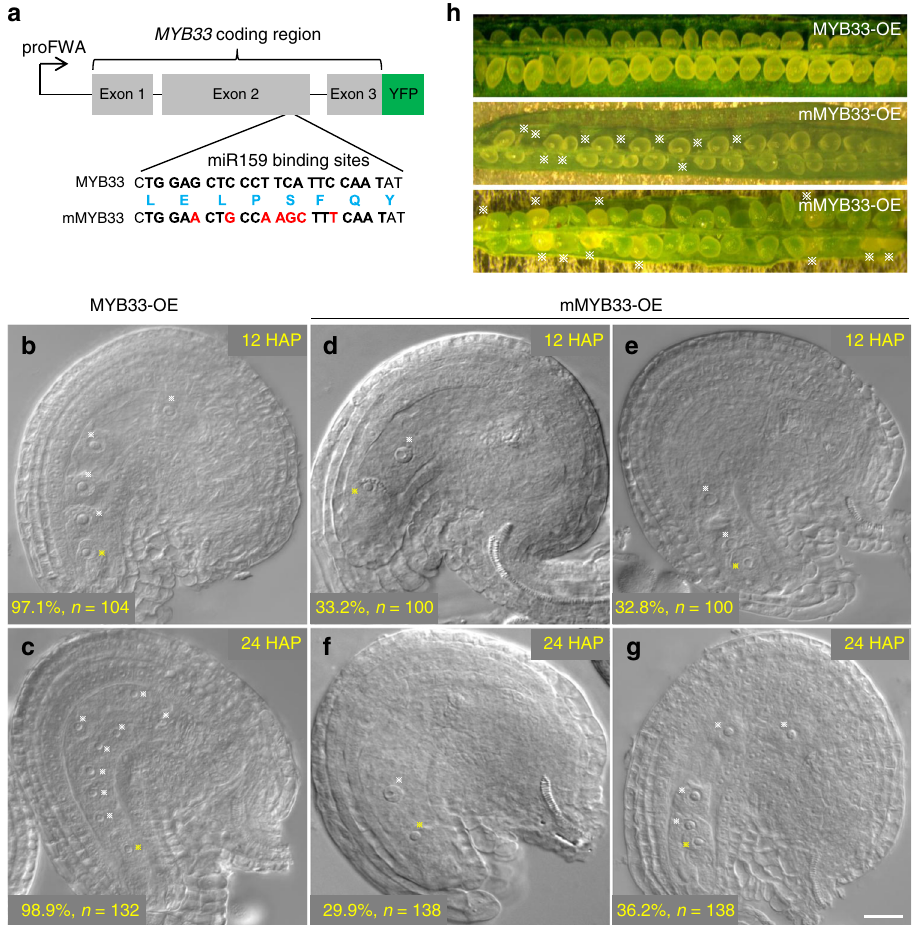
Fig. 5 Over-expression of mMYB33 causes defective endosperm nuclear divisions. The proFWA::MYB33-YFP (MYB33-OE) or proFWA::mMYB33-YFP (mMYB33-OE) transgene driven by the FWA promoter made in the vector pB7YWG2. The alteration to the nucleotide sequence in the miR159 binding sites of MYB33 is shown, and nucleotides highlighted in red for mMYB33 are those differing from the wild type ( MYB33 ). The unaltered amino acid sequences are shown in blue. The nucleotides in bold indicate the 21 nt miR159 binding sites. Gray boxes indicate three exons of MYB33 . b – g DIC imaging of endosperm nuclear divisions from MYB33-OE b , c and mMYB33-OE d – g transgenic plants at indicated time (HAP), respectively. White stars indicate endosperm nuclei or the central cell nucleus. Yellow stars indicate the fused nucleus by the egg cell and the sperm. % indicates the ratio of developing seeds similar to the representative image relative to total ones. n represents total numbers of observed developing seeds for each category. Scale bar, 20 µ m. Representative images for dissected seeds from MYB33-OE or mMYB33-OE transgenic plants. Normal seeds after 6 days are oval and dark green, white stars indicate aborted seeds. Source data are provided in the accompanying Source Data fi